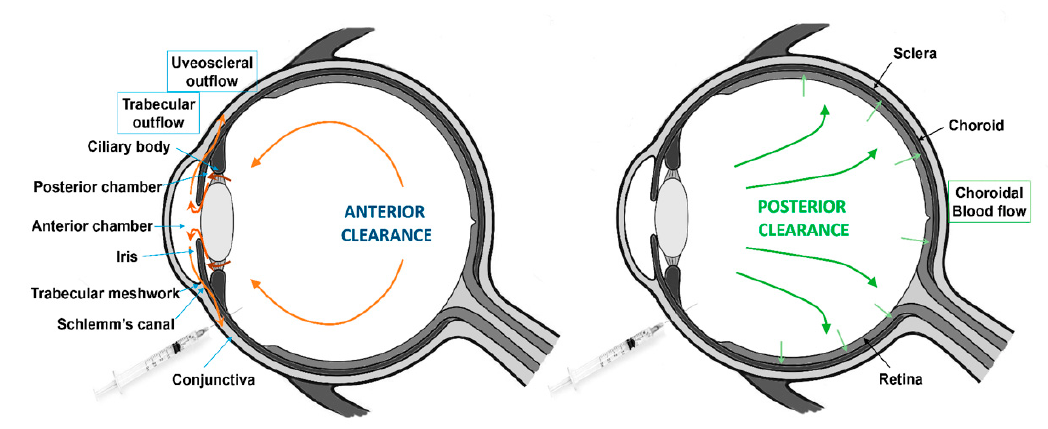
Figure 4. Schematic representation of the anterior and posterior clearance from the vitreous humor.